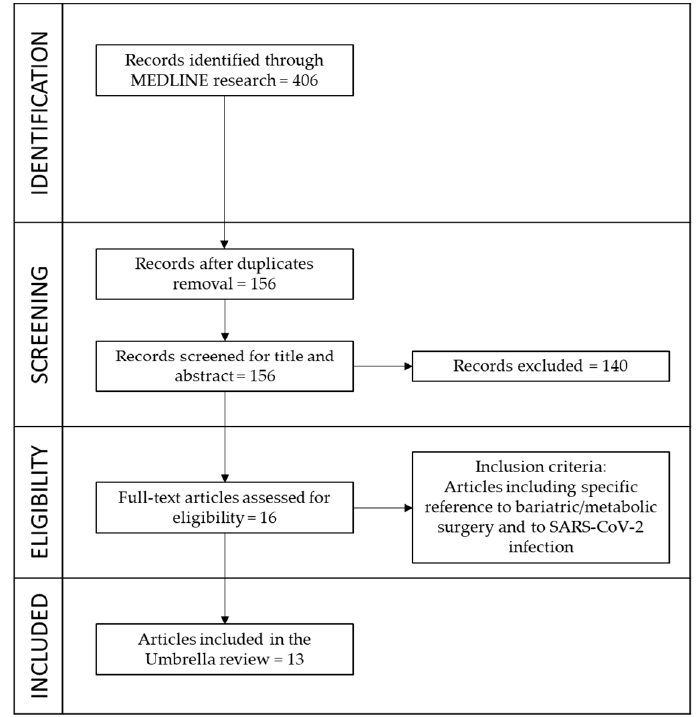
Figure 1. Flow diagram of study selection. The characteristics of all the articles are listed in Table 1. Table 1. Summary of characteristics of included studies in most recent reviews, systematic reviews, and meta-analyses.